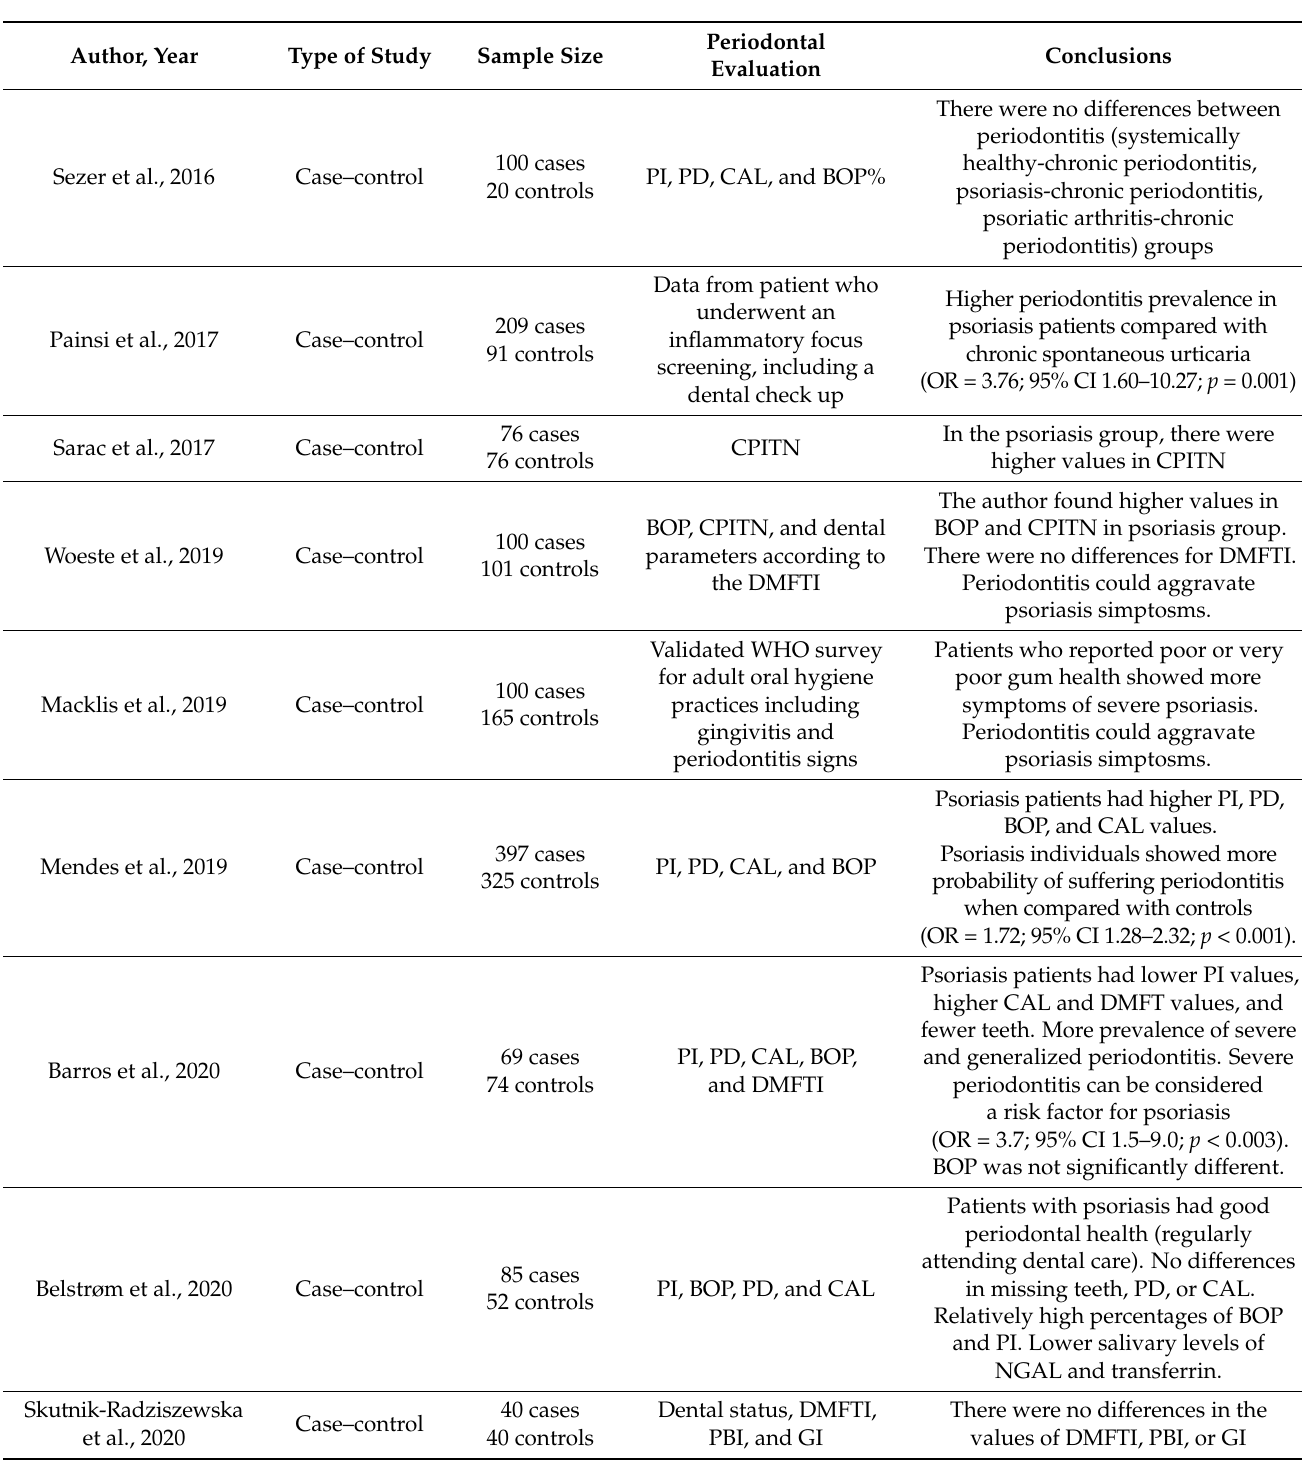
Table 4. General characteristics of the studies analysed in this